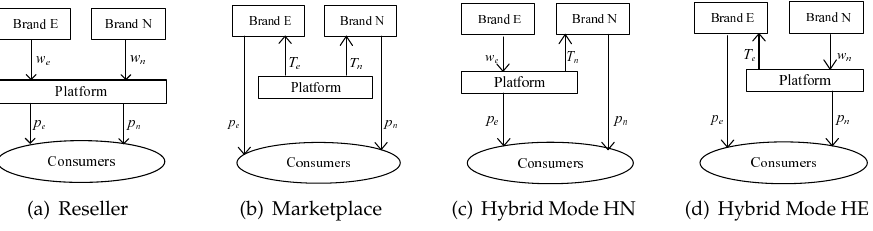
Figure 1. Four alternative mode